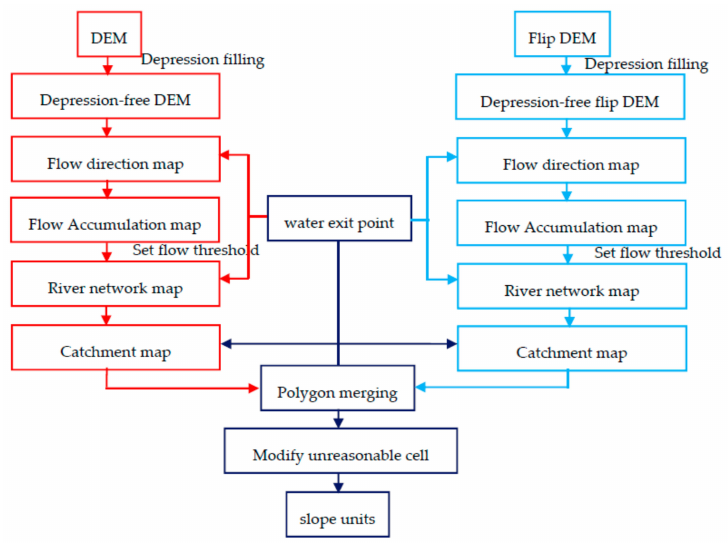
Figure 2. Construction process of the slope